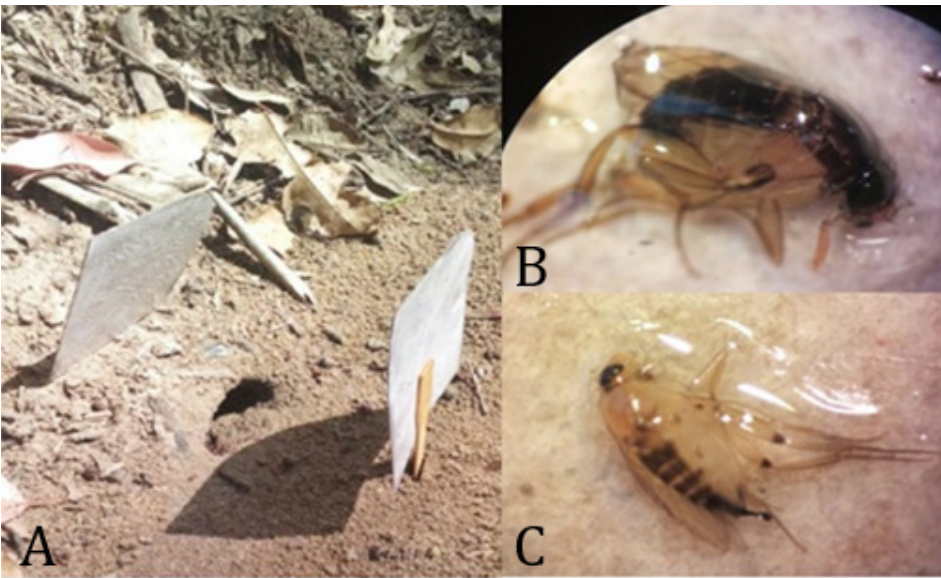
Fig 1. (A) Details and distribution of the traps, (B) Phorids captured from the genus Myrmosicarius , (C) Phorids captured from the genus Eibesfeldtphora.